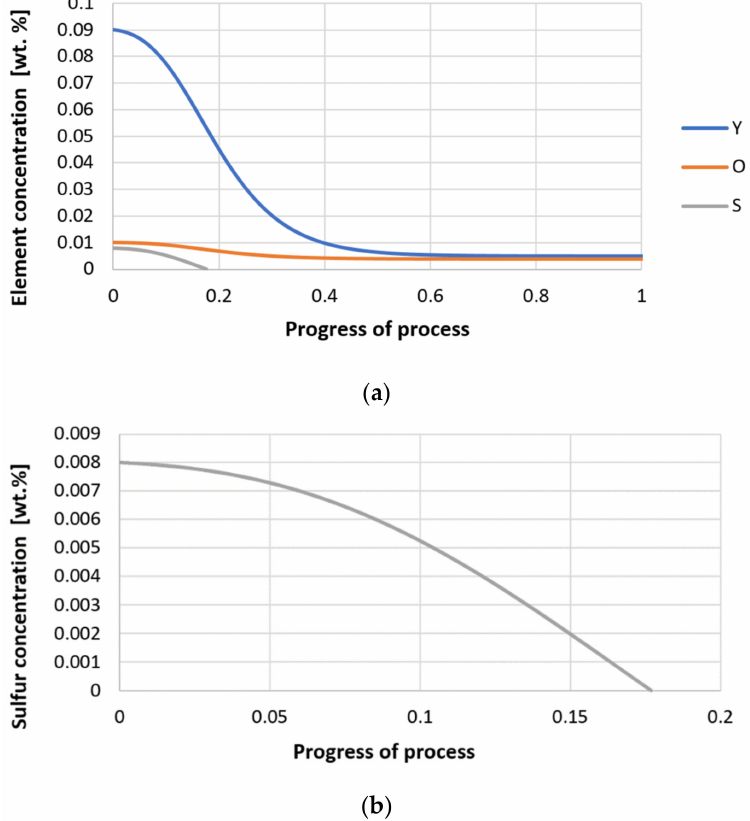
Figure 28. ( a , b ) Change of component concentration during the growth of a bi-component nucleus (Y 2 O 3 –Y 2 S 3 ) in steel 3 (for r 0 = 1 µ